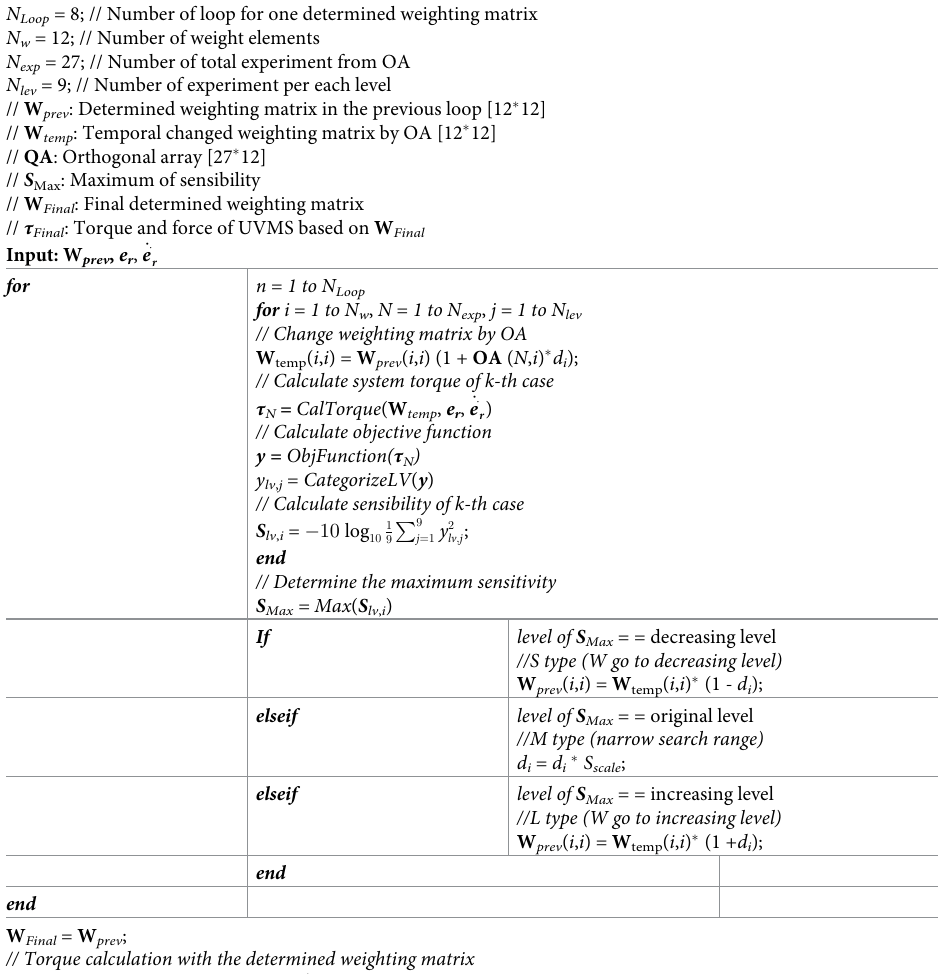
Table 5. Real-time Taguchi weight pseudocode. N Loop = 8; // Number of loop for one determined weighting matrix N